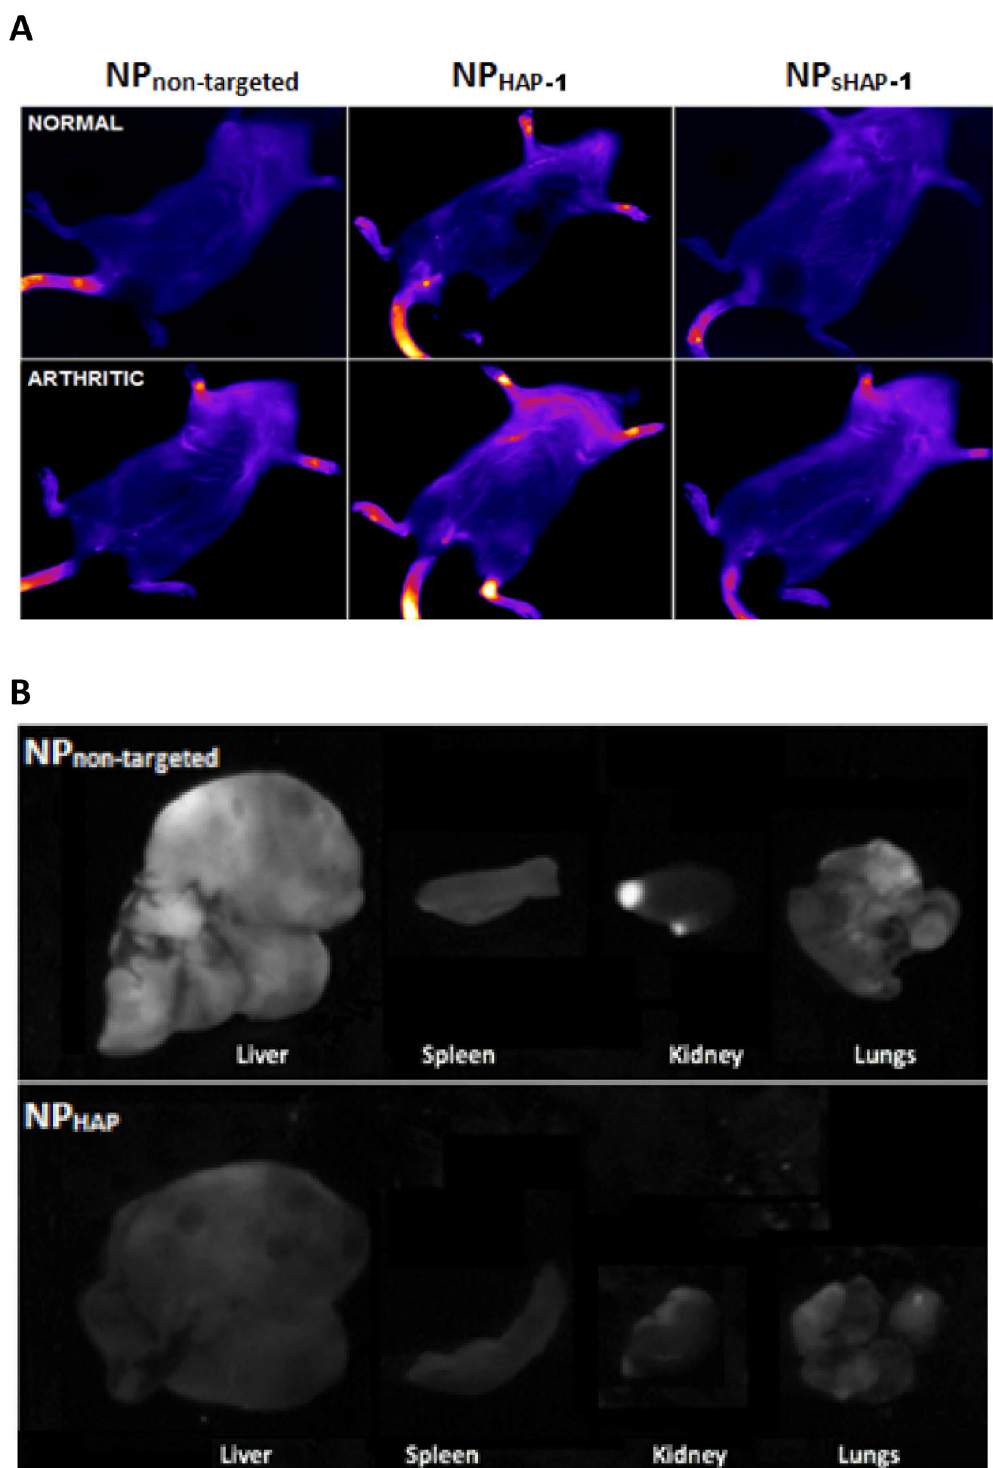
Figure 3. In vivo NP localization in normal and arthritic rats using near infrared imaging (NIR). ( A ) Localization of NP non-targeted , NP HAP-1 and NP sHAP-1 24 h post-injection. No specific accumulation was seen in normal rats treated with NP non-targeted and NP sHAP-1 . In arthritic rats, slight accumulation to the inflamed joints was observed for NP non-targeted and NP sHAP-1 . For NP HAP1 , localization to the joints was observed in both normal and arthritic rats. ( B ) Ex vivo imaging of liver, spleen, kidney, and lungs extracted from NP non-targeted , NP HAP-1